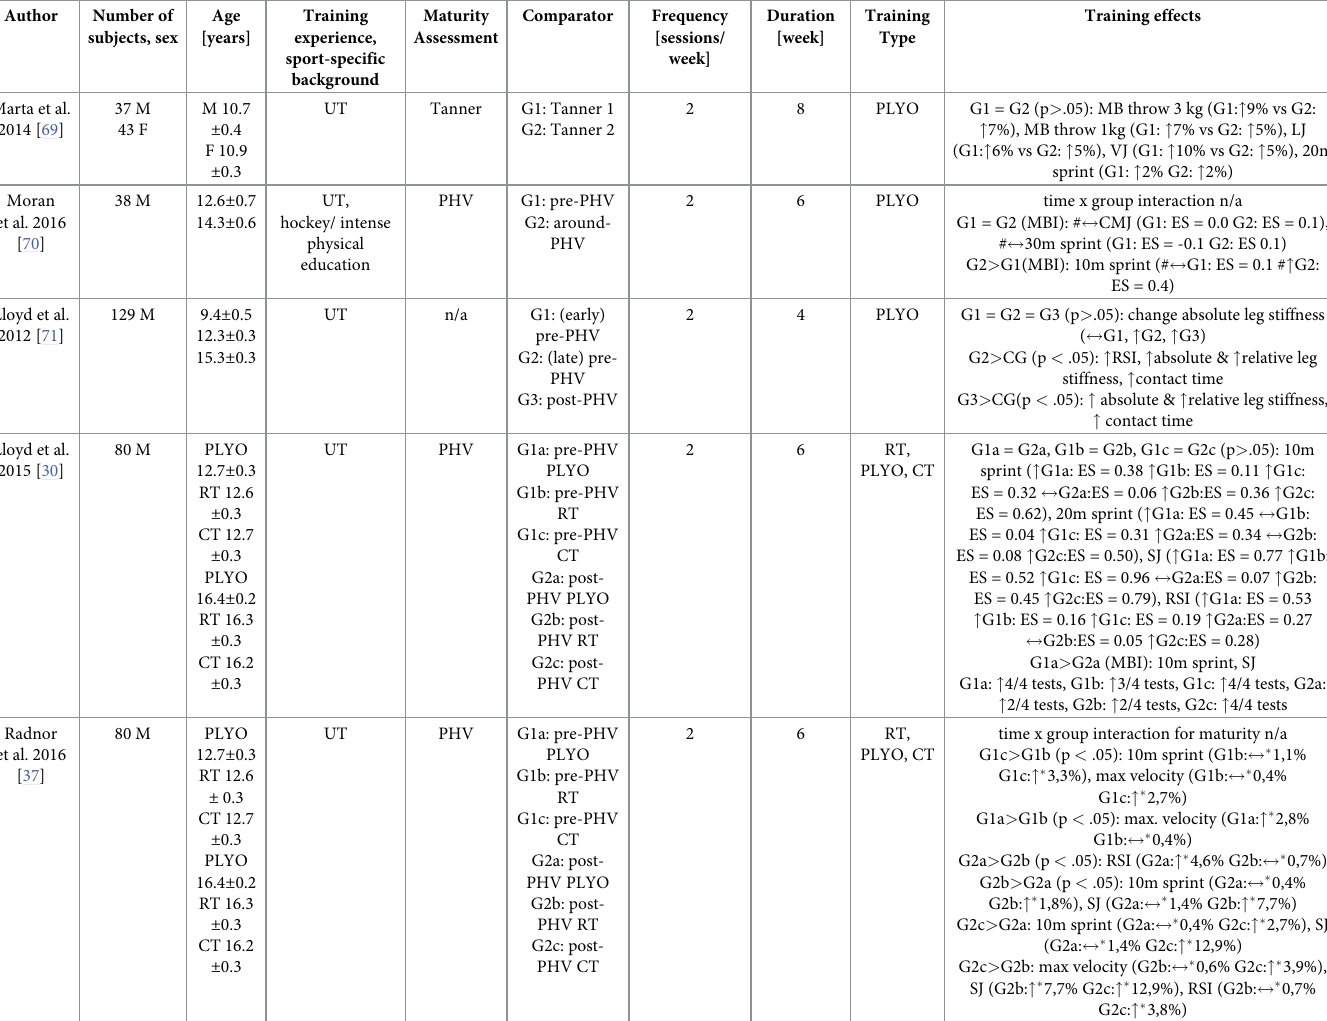
Table 8. Influence of the moderating variable ‘maturation’ on plyometric training induced improvements in components of physical